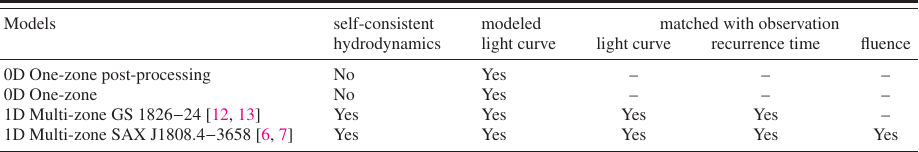
Table 1. XRB models and the respective observables that have been studied. Models self-consistent modeled matched with observation hydrodynamics light curve light curve